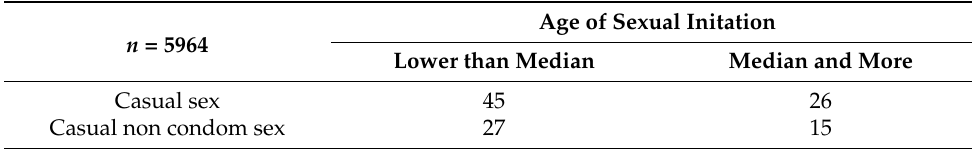
Table 6. Casual sex depending on age of sexual initiation. All data contained in the table are presented as a percentage.